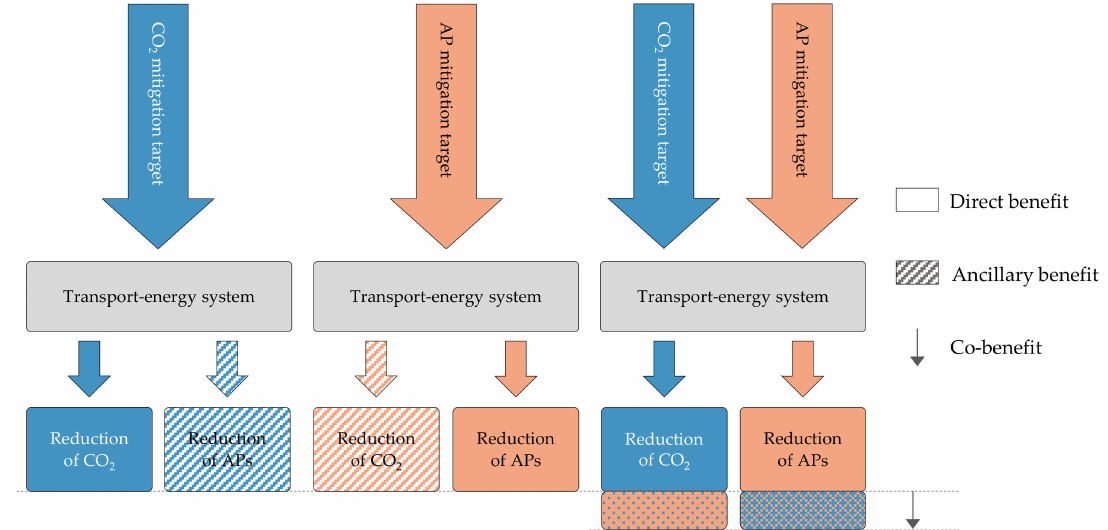
Figure 1. Conceptual framework for assessing the direct , ancillary , and co-benefits of mitigation measures targeting carbon dioxide (CO 2 ) and air pollutant (AP)